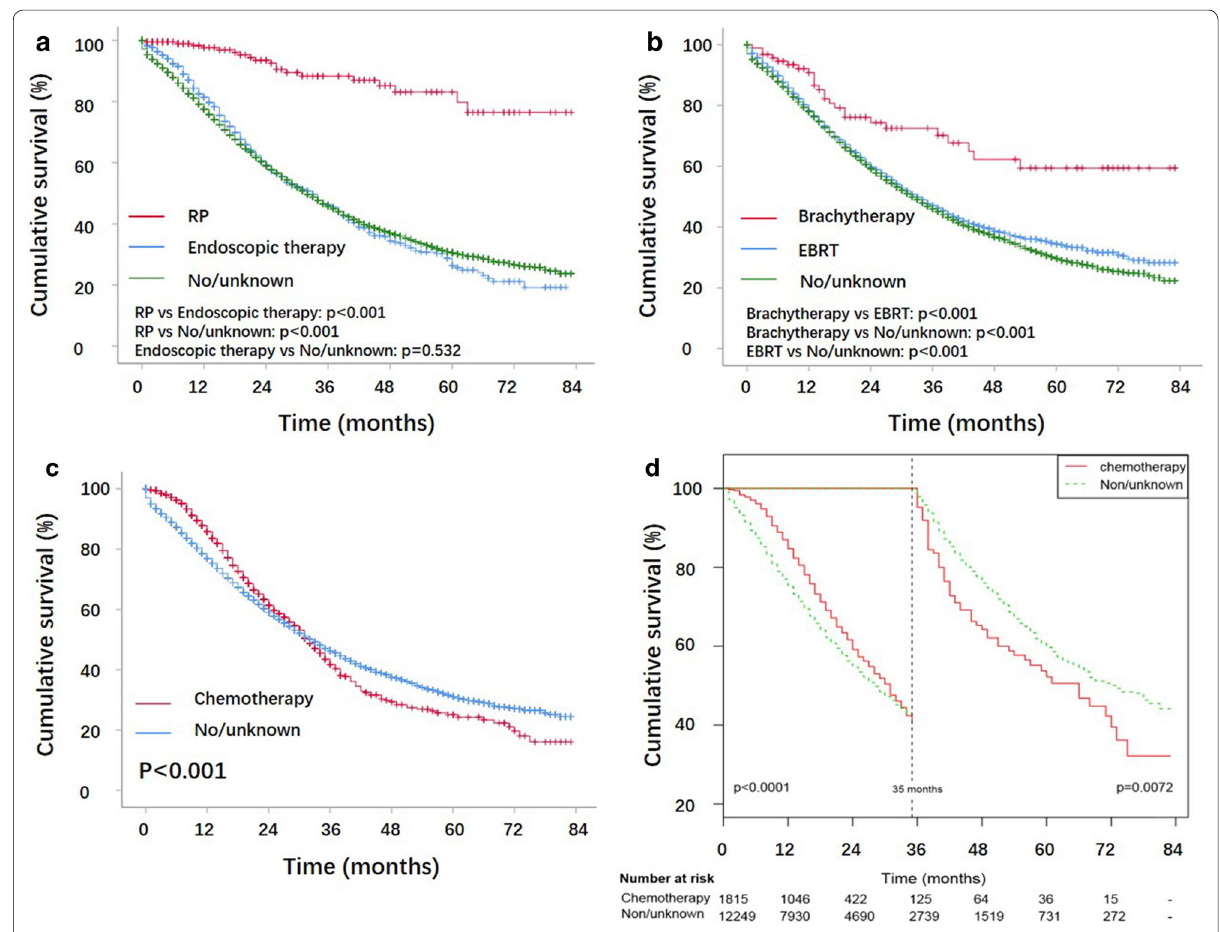
Fig. 4 Kaplan-Meier survival curves and log-rank tests showing OS in prostate cancer patients with bone-only metastases. a OS differences between patients who underwent RP, endoscopic therapy and non/unknown surgery. b OS differences between patients who underwent brachytherapy, EBRT and non/unknown RT. c OS differences between patients who underwent chemotherapy and non/unknown chemotherapy. d Landmark analysis discriminating between patients who underwent chemotherapy and non/unknown